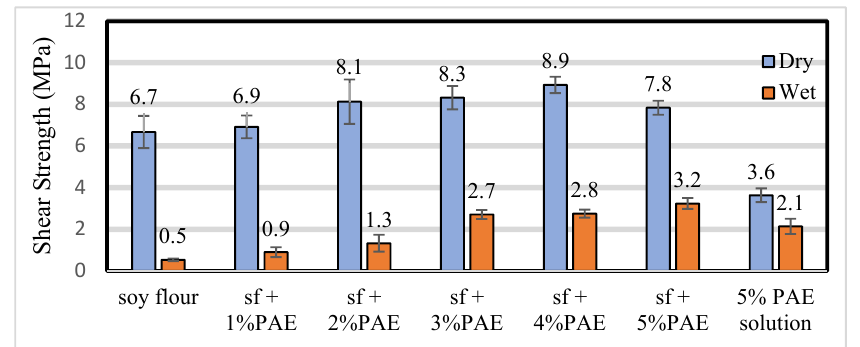
Figure 2. ABES shear strength (MPa), dry and wet, of the soy adhesives (sf, 25% solids) with very low amounts of PAE and a 5% PAE solution with no soy flour.